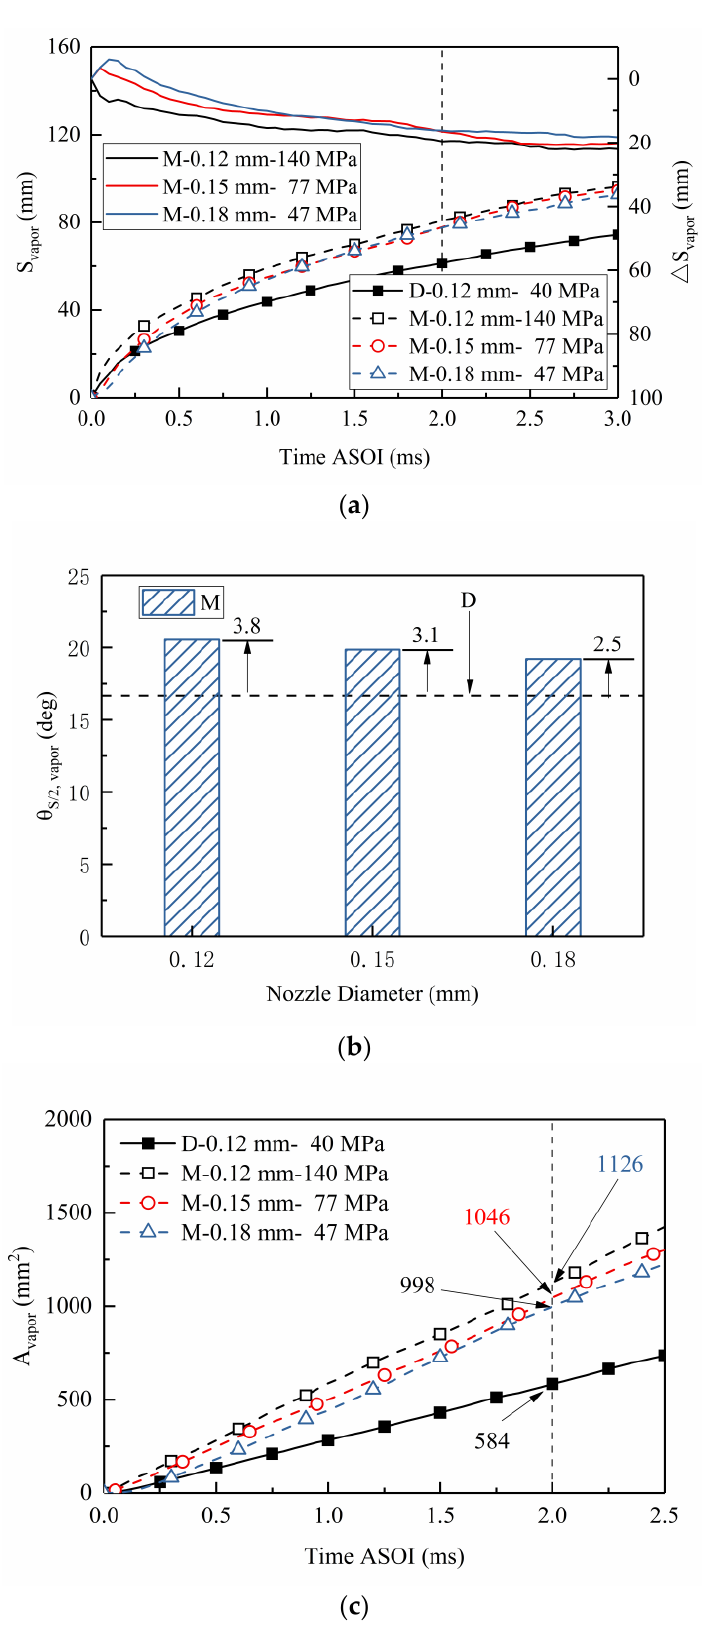
Figure 14. Quantitative analysis of the vapor phase spray under different strategies. ( a ) Spray tip penetration results. ( b ) Spray angle results. ( c ) Spray area results.